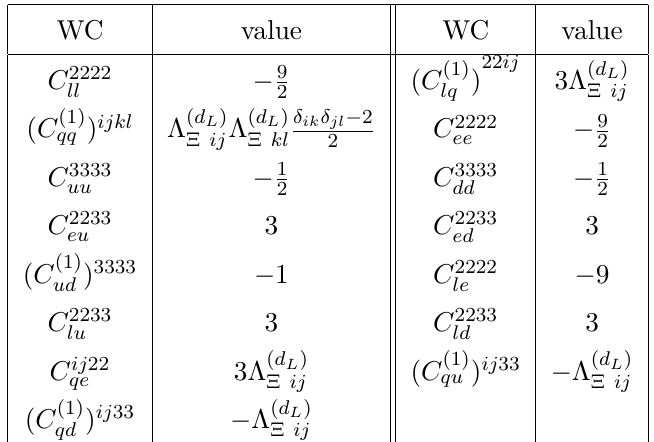
Table 4 . Non-zero tree-level dimension-6 SMEFT WCs predicted by integrating the Z 0 out of the B 3 − L 2 Z 0 model, in units of g 2 , in the Warsaw basis [96]. Here the EFT matching scale Z 0 is Λ = M Z 0